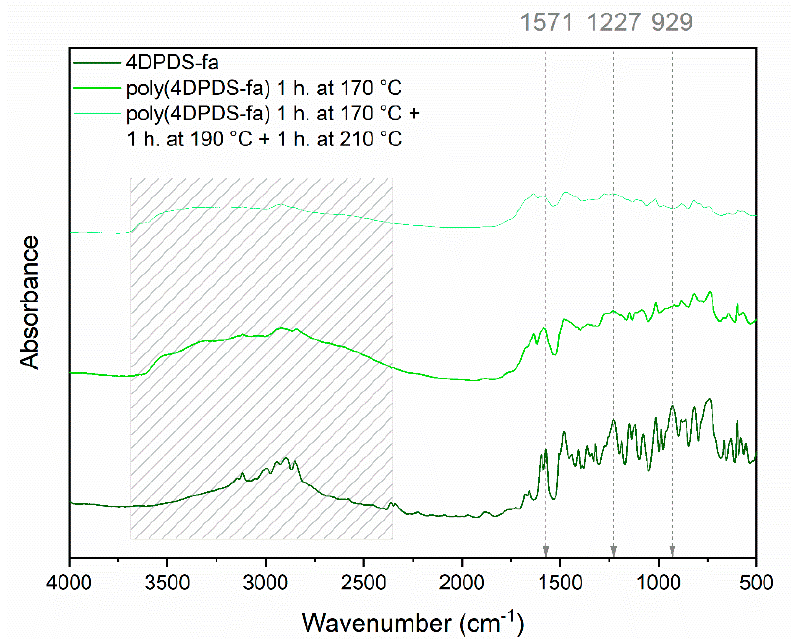
Figure A8. FTIR spectra of 4DPDS-fa, poly(4DPDS-fa) after curing at 170 °C for 1 h, and poly(4DPDS-fa) after curing at 170 °C for 1h and post-curing at 190 °C for 1h and 210 °C for 1 h.